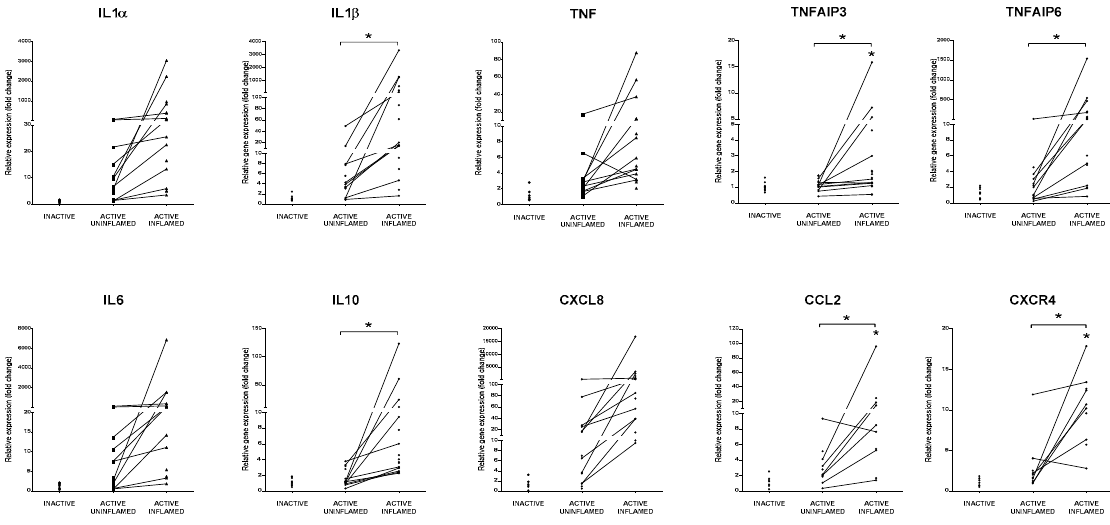
Figure 3. Global upregulation of proinflammatory cytokines and anti-inflammatory molecules indicate the presence of inflammatory response. The relative gene expression of IL1 α , IL1 β , TNF, TNFAIP3, TNFAIP6, IL6, IL10, CXCL8, CCL2 and CXCR4 cytokines, chemokines and anti-inflammatory genes is shown from inactive (left), active uninflamed (middle) and active inflamed (right) colon samples of IBD patients. Dots represent individual values, and the lines connect samples from the same IBD patient; * p < 0.05.